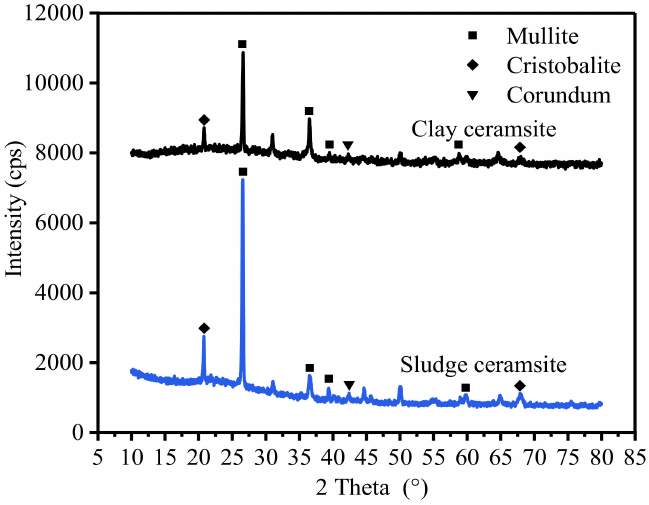
Figure 11. X-ray diffraction patterns of